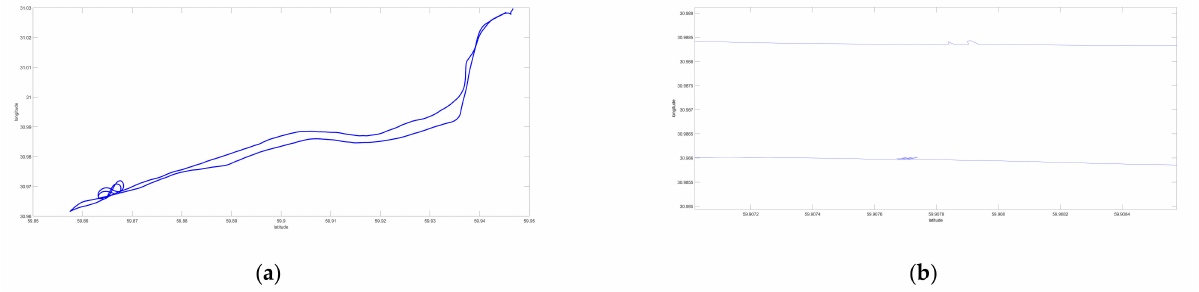
Figure 4. Vessel trajectory, obtained from the second antenna ( a ), vessel trajectory under the bridge, obtained from the second antenna ( b ).